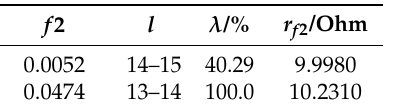
Table 6. Optimal solutions of f 2 when a fault occurred at each branch in set 2 for Case